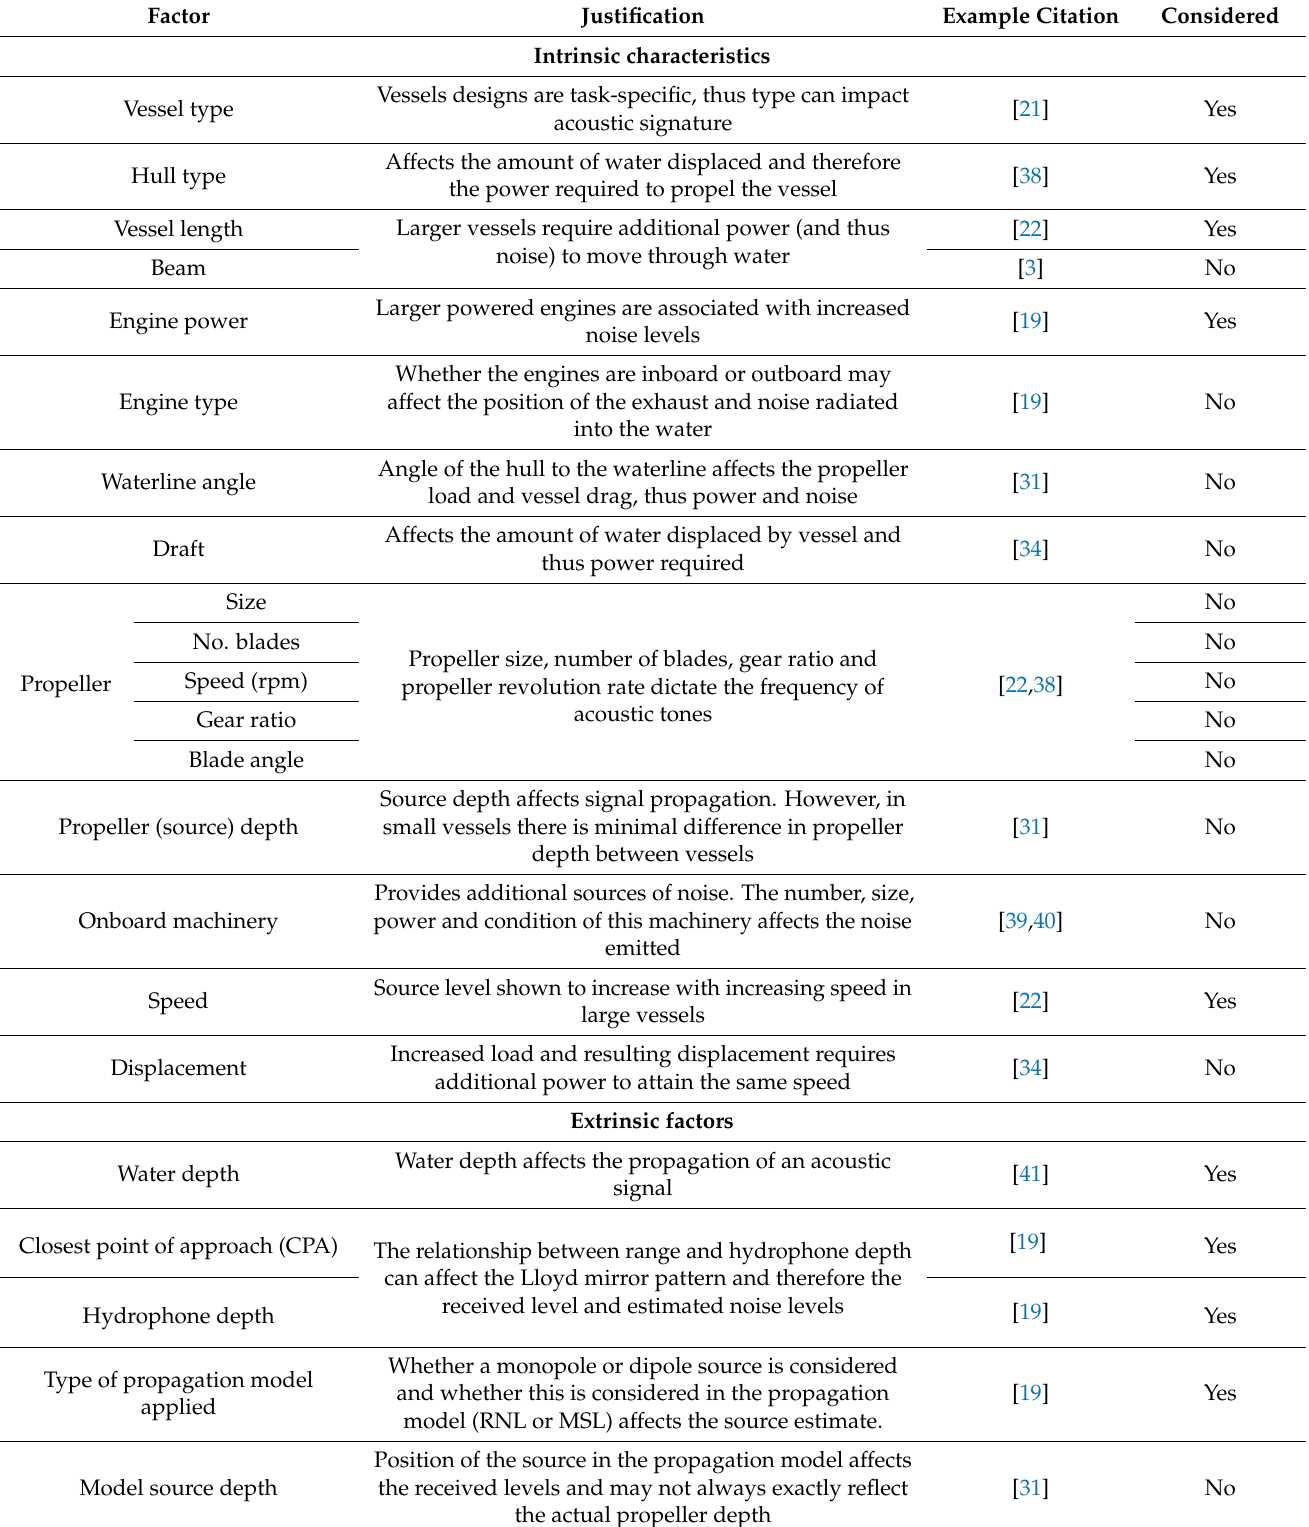
Table 2. Factors contributing to variations in source level and justifications for consideration in modelling in this